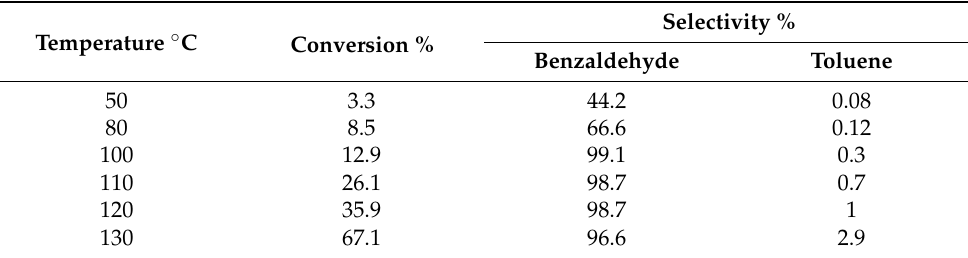
Table 3. Effect of temperature on benzyl alcohol oxidation using 1%Cu–Pd/support with 1:1 mole ratio